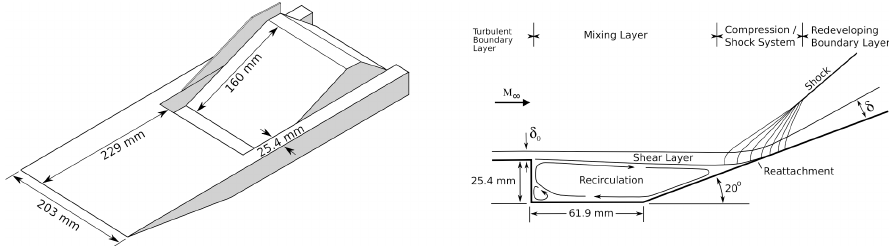
Figure 1. Settles configuration and flow field structure